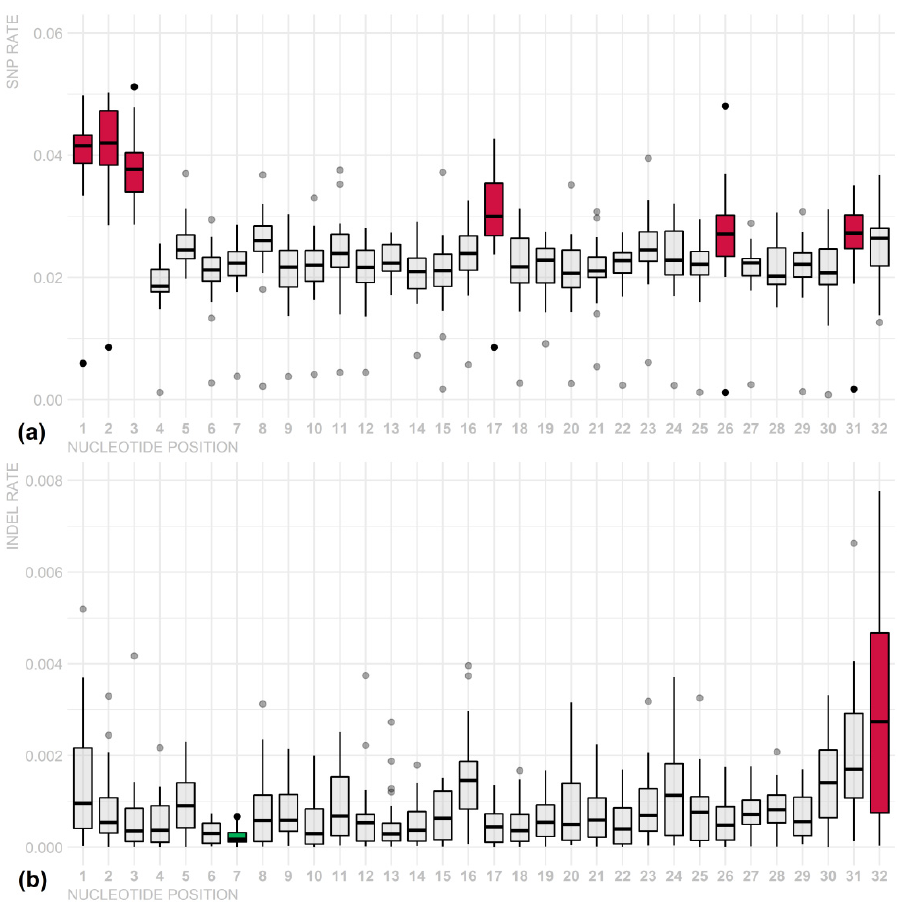
Figure 3. SNP ( a ) and INDEL ( b ) variation rates in piRNA regions per chromosome and nucleotide. Less conserved nucleotides are shown in red, and more conserved nucleotides are shown in blue. Although there were significant differences among some nucleotides ( p- value < 0.05), this result suggests that there is no specific region of piRNA that stands out as a seed region.